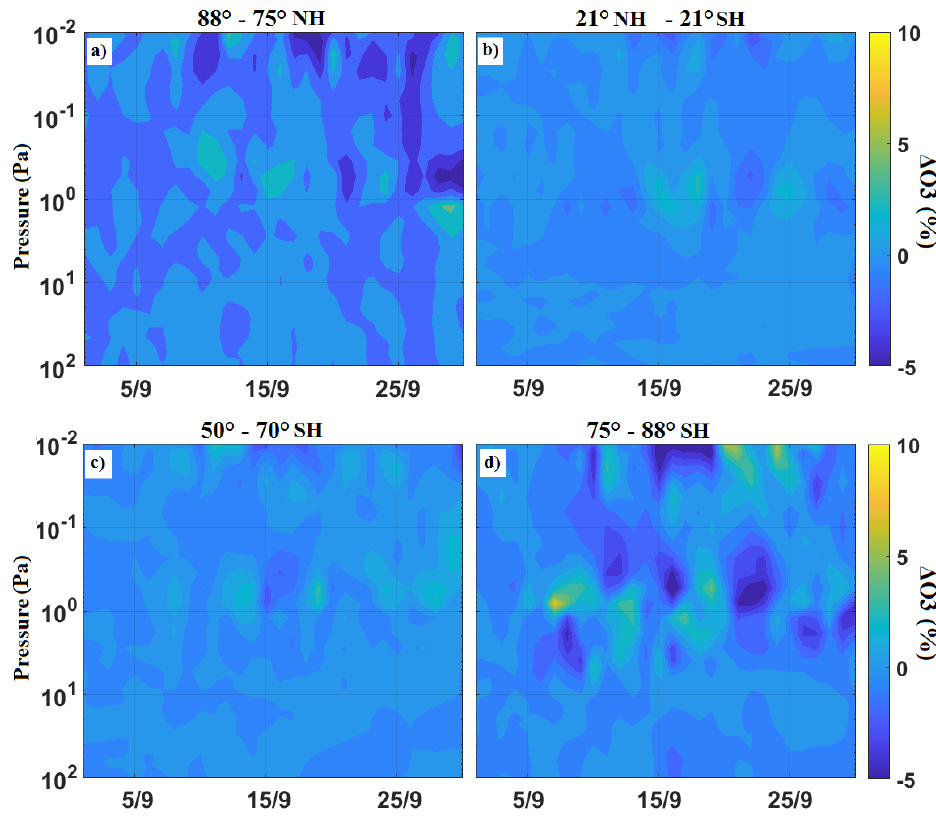
Figure 5. The response of ozone (O 3 ) to solar flares X9.3 on 6 September and X8.2 on 10 September 2017 in the northern polar latitudes ( a ), equatorial latitudes ( b ), southern latitudes ( c ), and southern polar latitudes ( d